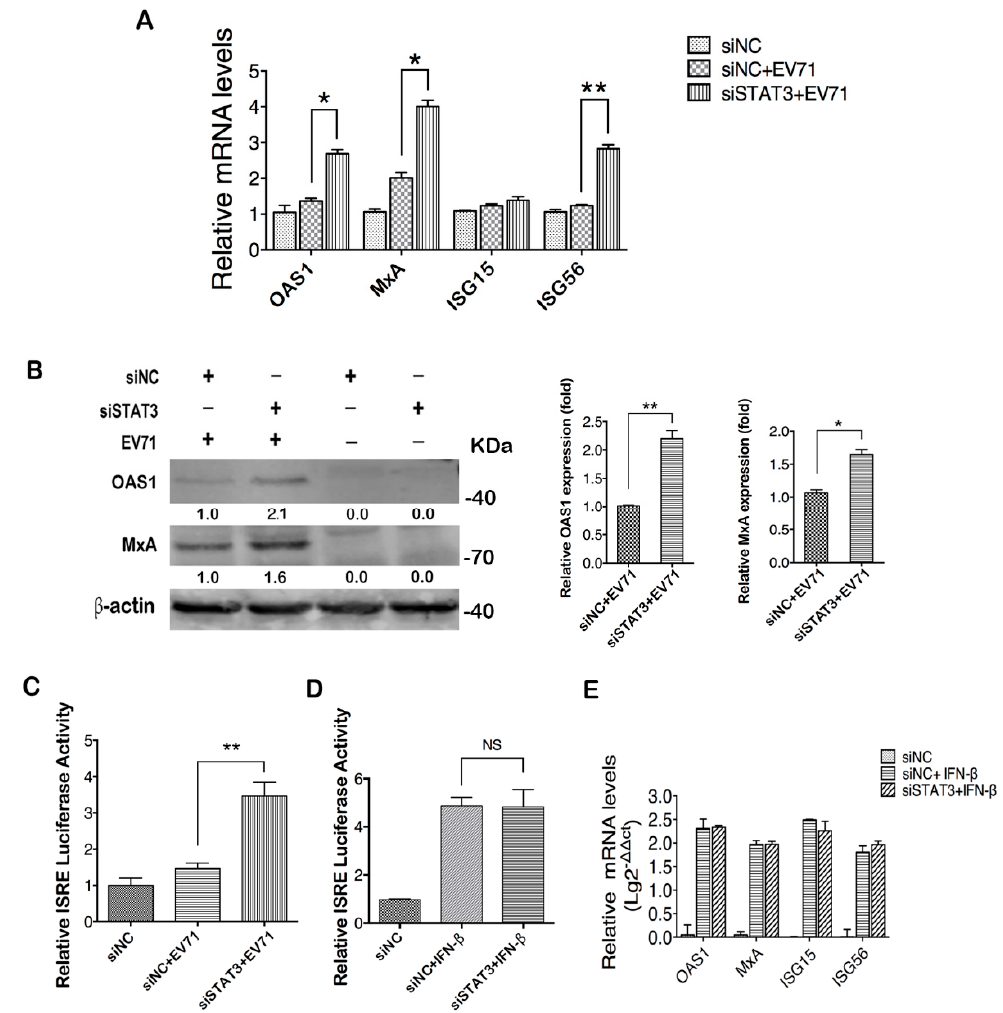
Figure 4. STAT3 knockdown facilitated ISG expression in EV71-infected T98G cells. ( A ) mRNA levels of ISGs from EV71-infected STAT3 KD T98G cells were analyzed by real-time PCR. ( B ) Protein levels of MxA and OAS1 at 24 h post EV71 infection were analyzed by western blot. Relative expression levels of indicated proteins were calculated as described above. The value in the group with siNC transfection and EV71 infection was set as 1.00 (100%). ( C ) STAT3 knockdown increased ISRE activity in EV71 infected cells. Cells were co-transfected with STAT3 siRNA, pISRE-Luc and pGMR-TK; 36h post transfection, the cells were infected with EV71 for 24 h and cell lysates were prepared for dual luciferase activity determination. ( D ) ISRE activity in IFN- β treated cells was not affected by STAT3 knockdown. Post co-transfection of STAT3 siRNA, pISRE-Luc and pGMR-TK. Cells were treated with IFN- β for 12 h, and dual luciferase activity of the cell lysates was determined. ( E ) Expression levels of ISG mRNAs were not affected by STAT3 knockdown in IFN- β treated cells. T98G cells with or without STAT3 knockdown were treated with IFN- β and total RNAs were extracted; the mRNA levels of OAS1, MxA, ISG15 and ISG56 were analyzed by real-time PCR, * p < 0.05, ** p <